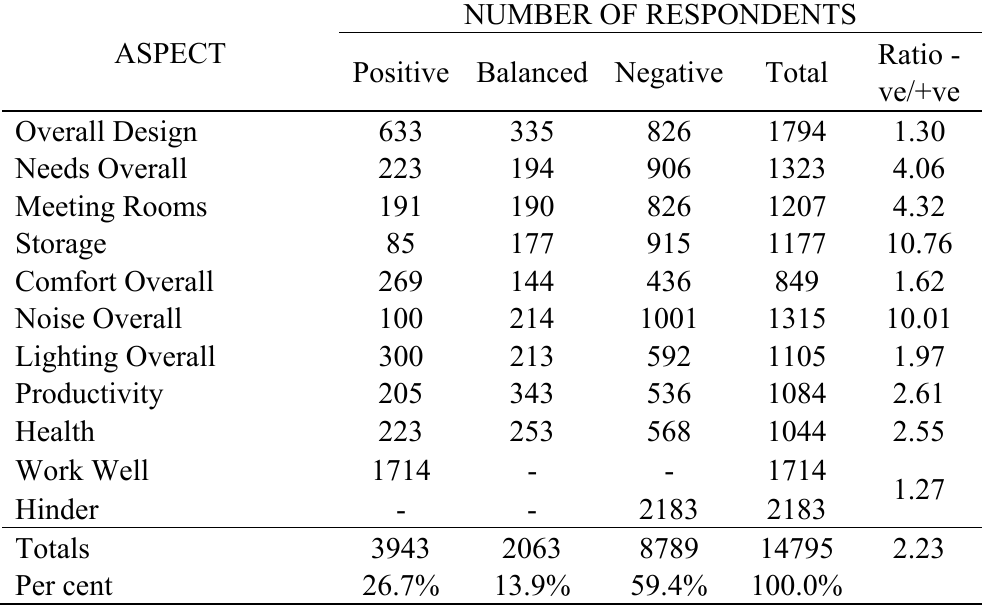
Table 1. Overall numbers of respondents offering positive, balanced, and negative comments on twelve aspects of building